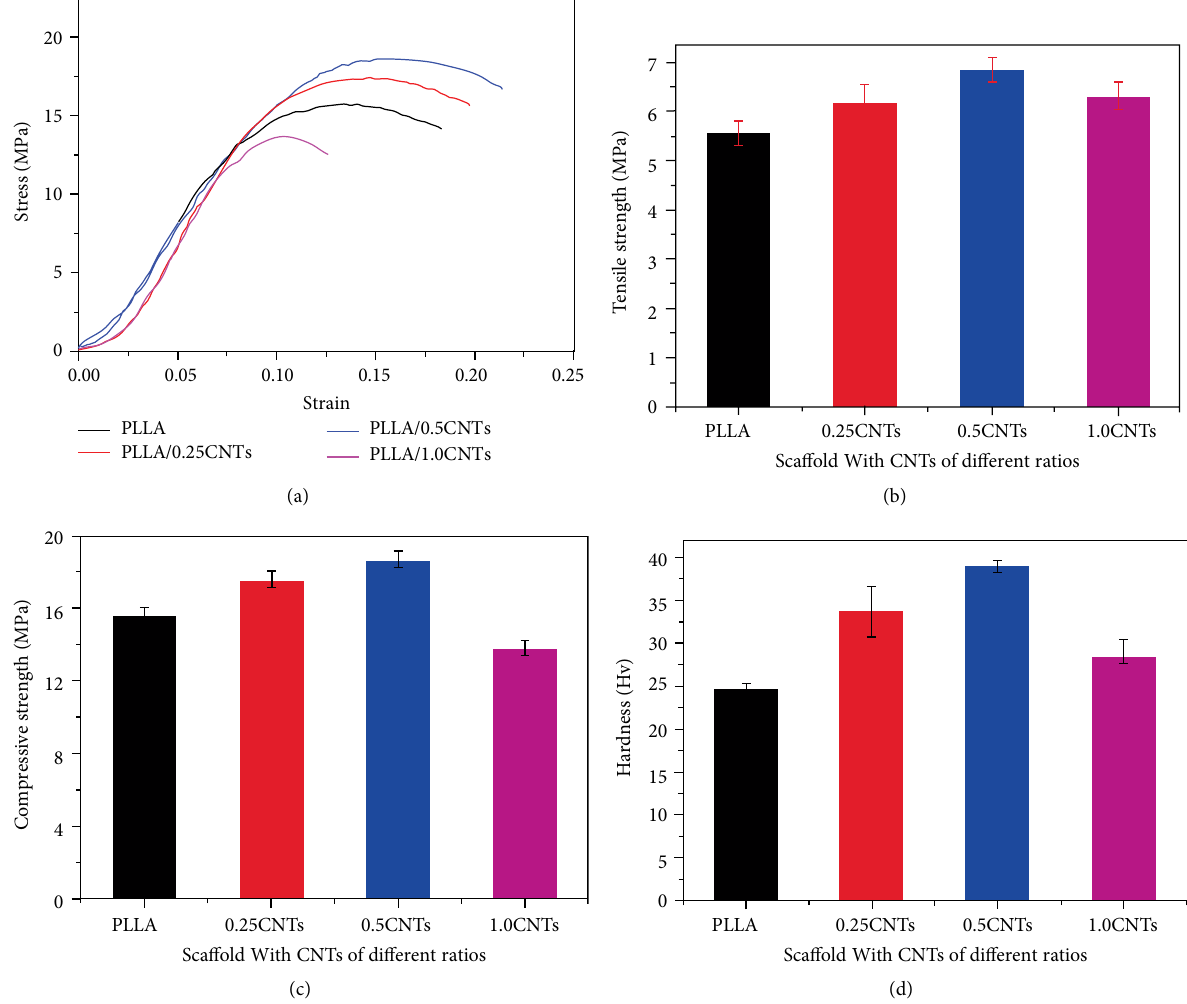
Figure 6: Tensile stress-strain curves (a), tensile strength (b), compressive strength (c), and hardness of PLLA and PLLA/CNTs composite scaffolds